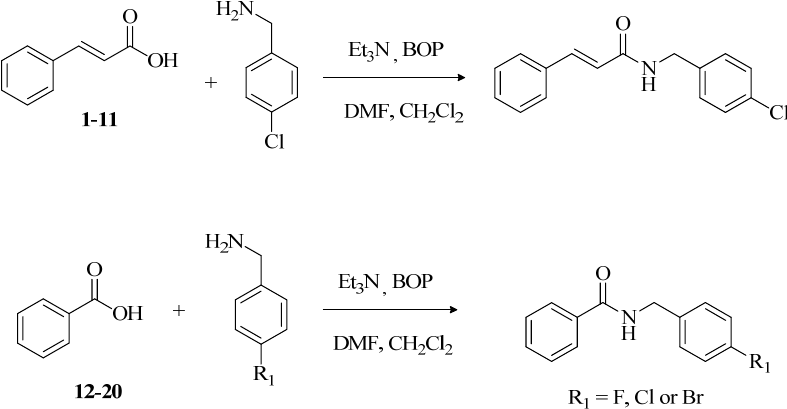
Scheme 1. General procedure for synthesis of halogenated amides.